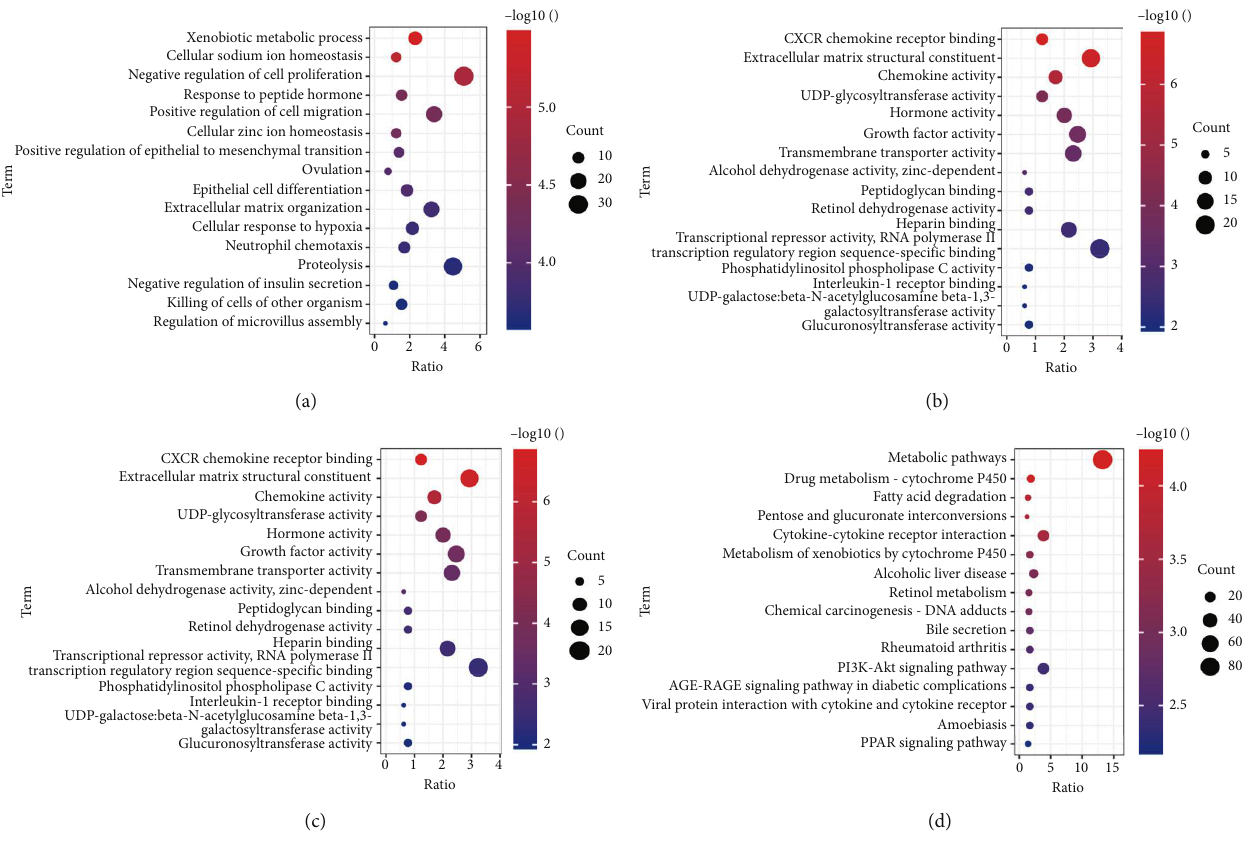
Figure 2: GO enrichment and KEGG pathway functional enrichment analyses of the DEGs. (a) The biological process (BP) of GO classi fi cation. (b) The cell component (CC) of GO classi fi cation. (c) The molecular function (MF) of GO classi fi cation. (d) KEGG pathway functional classi fi cation and